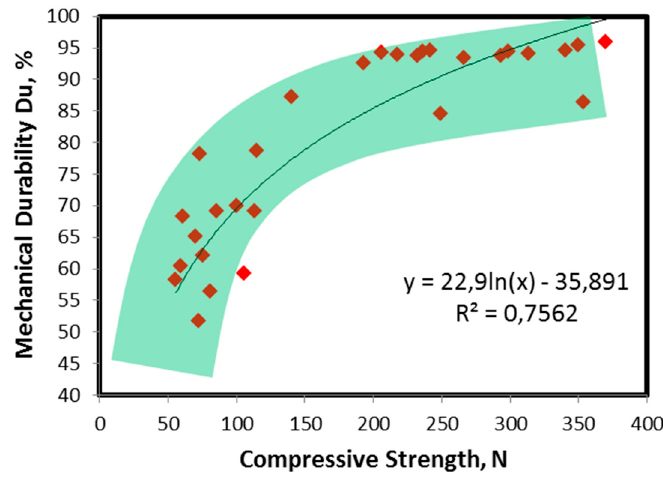
Figure 5. Relation between mechanical durability and compressive strength.